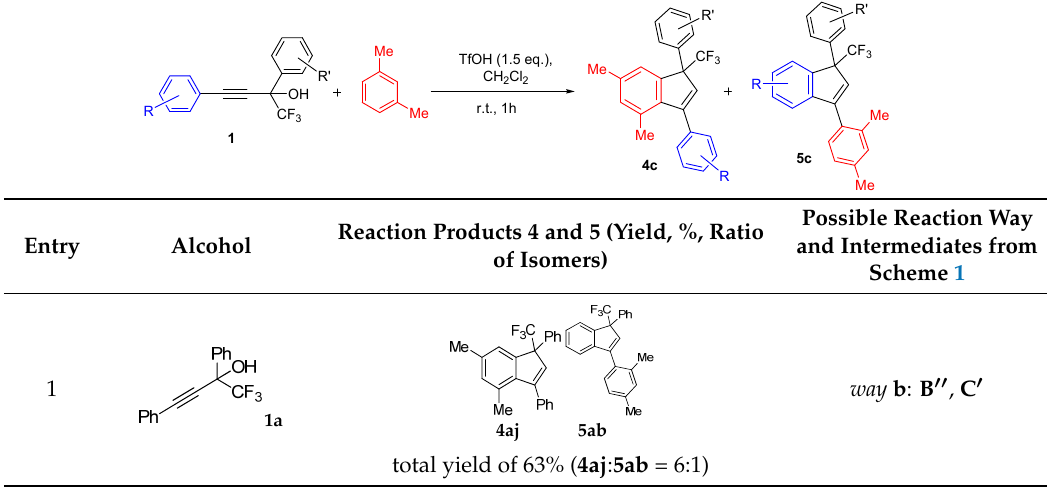
Table 5. TfOH-promoted reaction of 1 with m -xylene; reaction conditions: TfOH, CH 2 Cl 2 , molar ratio of 1 : m -xylene:TfOH = 1:1.1:1.5, room temperature, 1 h.